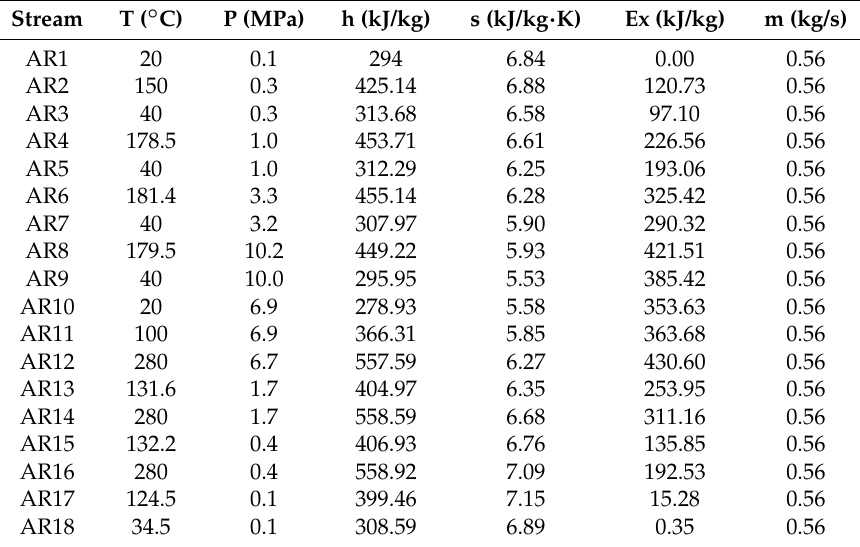
Table 5. Thermodynamic parameters of air stream.